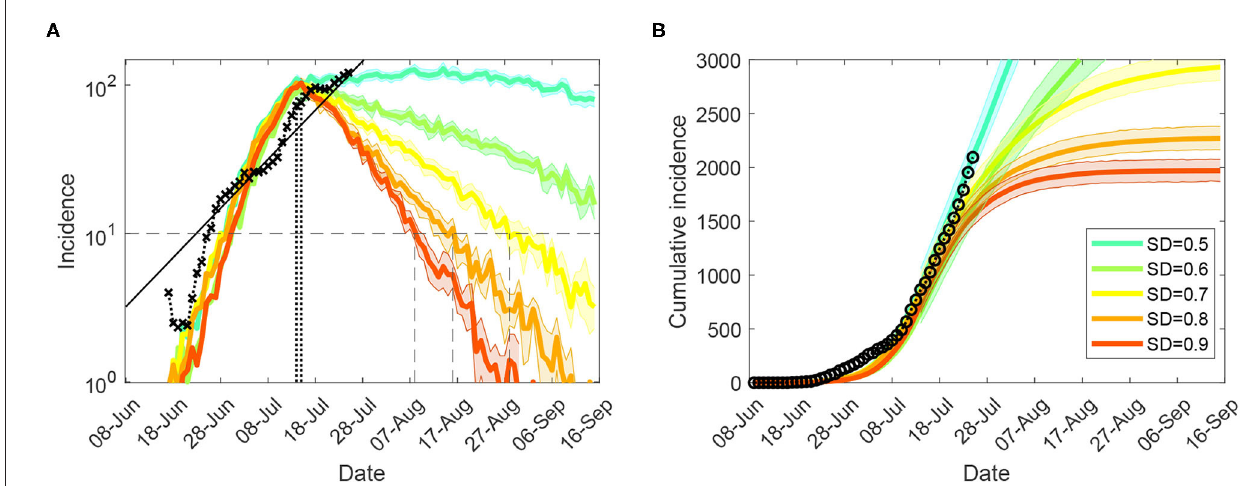
FIGURE 2 | Tight restrictions (NSW; progressive vaccination rollout; suppression threshold: 400 cases): counter-factual simulation scenarios, under lowest feasible interaction strengths ( CI c = CI w = 0.1, HQ c = HQ w = 0.1, SD c = 0.1, SC = 0.1), for (A) (log scale) incidence (crosses), and (B) cumulative incidence (circles). Traces corresponding to feasible social distancing (SD) compliance levels are shown as average over 10 runs (coloured profiles for SD varying in increments of 10%, i.e., between SD = 0.5 and SD = 0.9). Vertical lines mark the incidence peaks (dotted) and reductions below 10 daily cases (dashed). Each SD intervention, coupled with school closures, begins with the start of tighter lockdown, when cumulative incidence exceeds 400 cases (i.e., simulated day 31). The alignment between simulated days and actual dates may slightly differ across separate runs. Case isolation and home quarantine are in place from the outset.